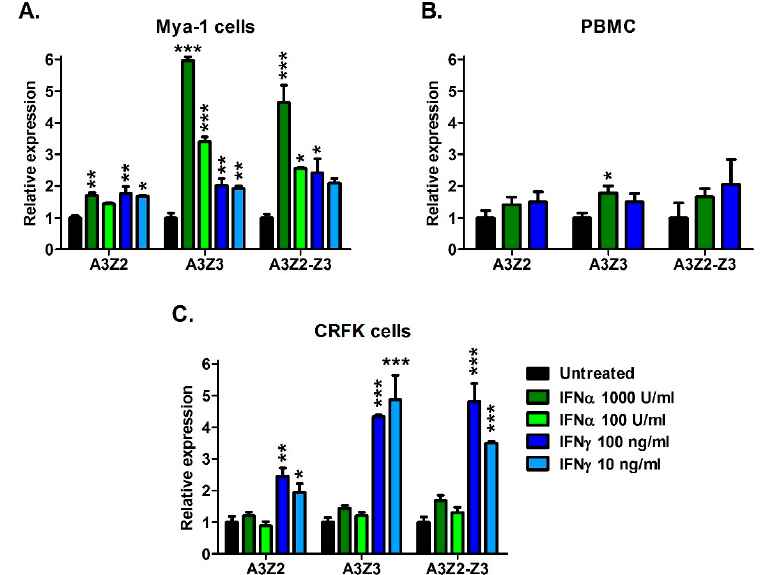
Figure 3. Interferons upregulate A3 mRNAs in a dose-dependent fashion in cat cell lines and PBMCs. ( A ) Mya-1 cells, ( B ) PBMCs, and ( C ) CRFK cells were treated with the indicated concentrations of feline interferon-alpha or feline interferon-gamma and A3 expression was determined 24 h after treatment. A3 expression is plotted and assessed statistically relative to untreated cells (***, p < 0.001; **, p < 0.01; *, p < 0.05). Experiments were conducted in triplicate and error bars represent standard errors of the